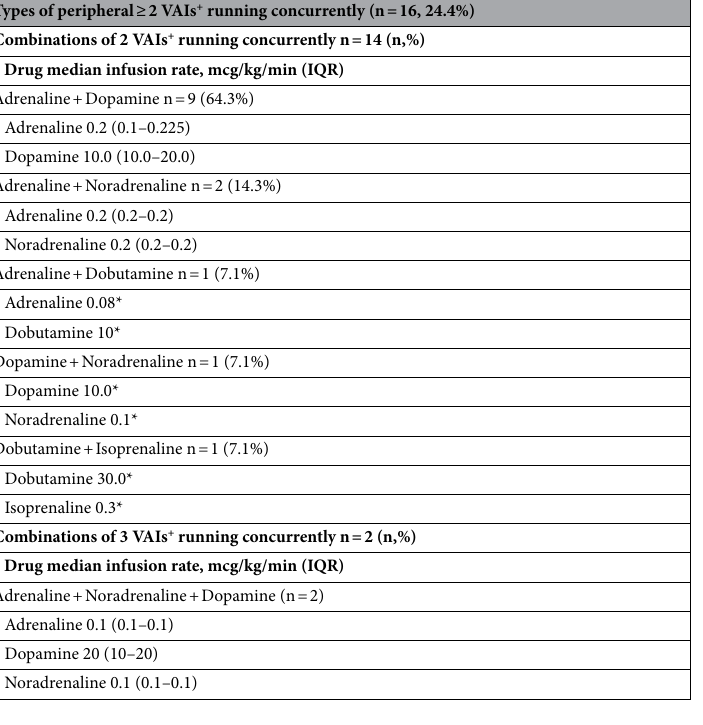
Table 3. Characteristics of patients requiring 2 or more concurrent peripheral vasoactive infusions. + VAIs (Vasoactive infusions), *no median (IQR) reported if n =